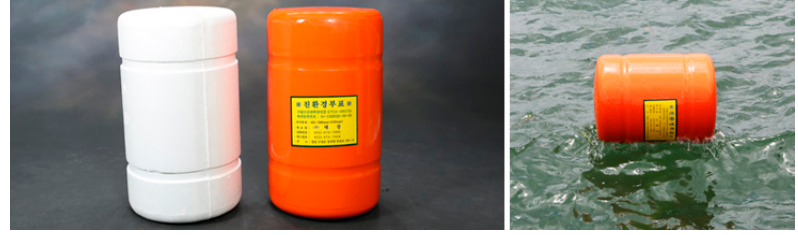
Figure 7. High-density expanded polystyrene (EPS).